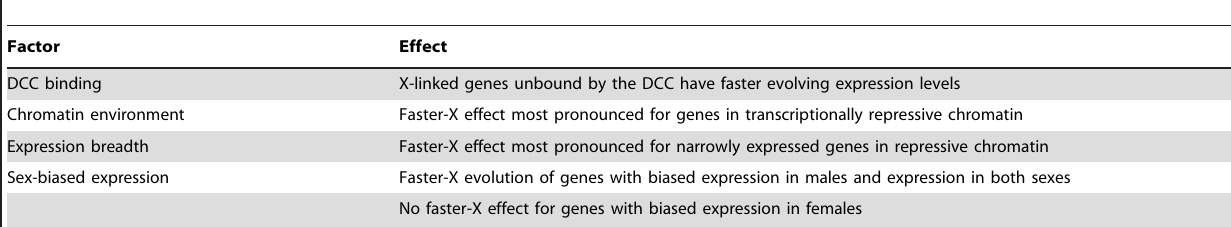
Table 1. Factors that contribute to the faster-X evolution of gene